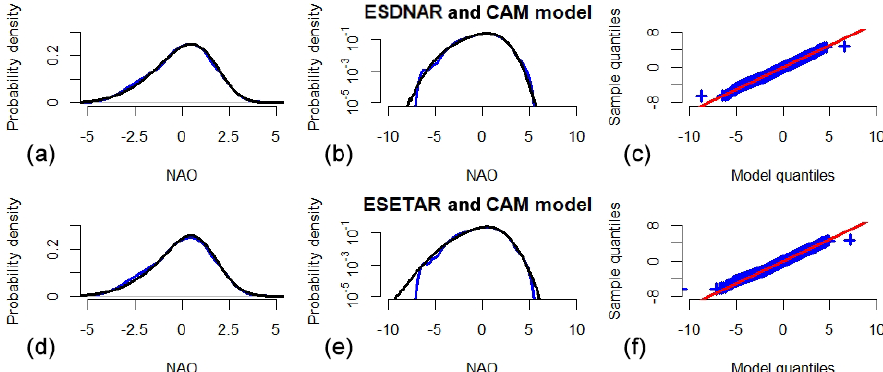
Figure 10. Properties of the ESDNAR model with CAM noise (a, b, c) , denoted as ESDNAR and CAM model, and the ESETAR model with CAM noise (d, e, f) , denoted as ESETAR and CAM model, models for the daily NAO winter index. The plots are generated in the same way as the plots in Fig.